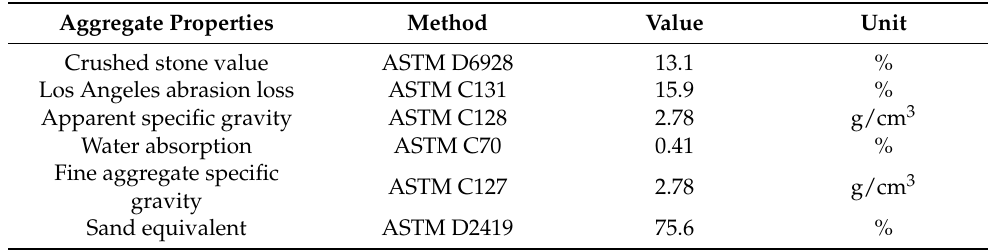
Table 5. Properties of aggregates.